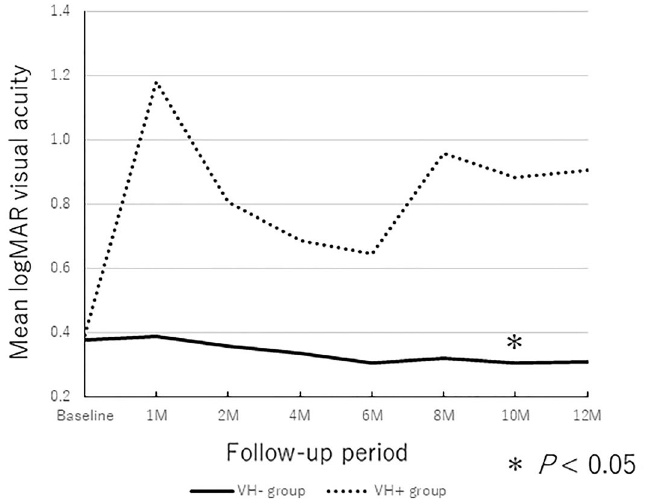
Figure 5. Changes in the BCVA during the 12-months follow-up period in patients with PCV. Only the mean BCVA at 10 months improved significantly compared with those at baseline in VH − group (* P <